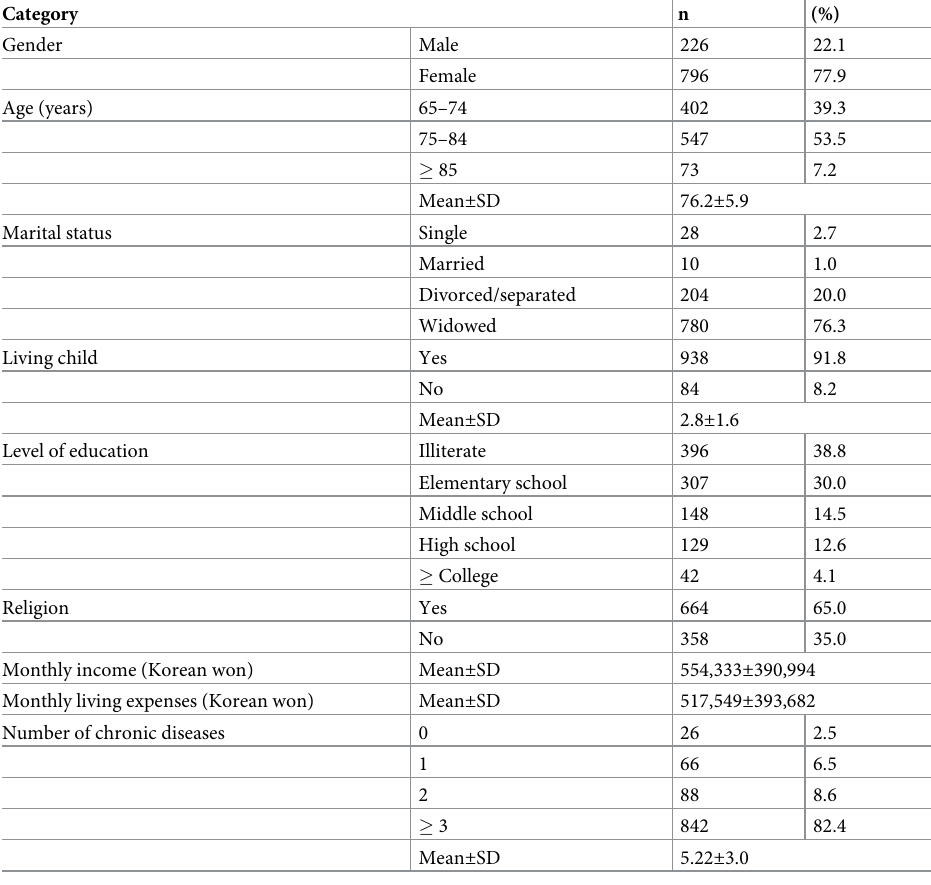
Table 1. General characteristics of the participants (N =